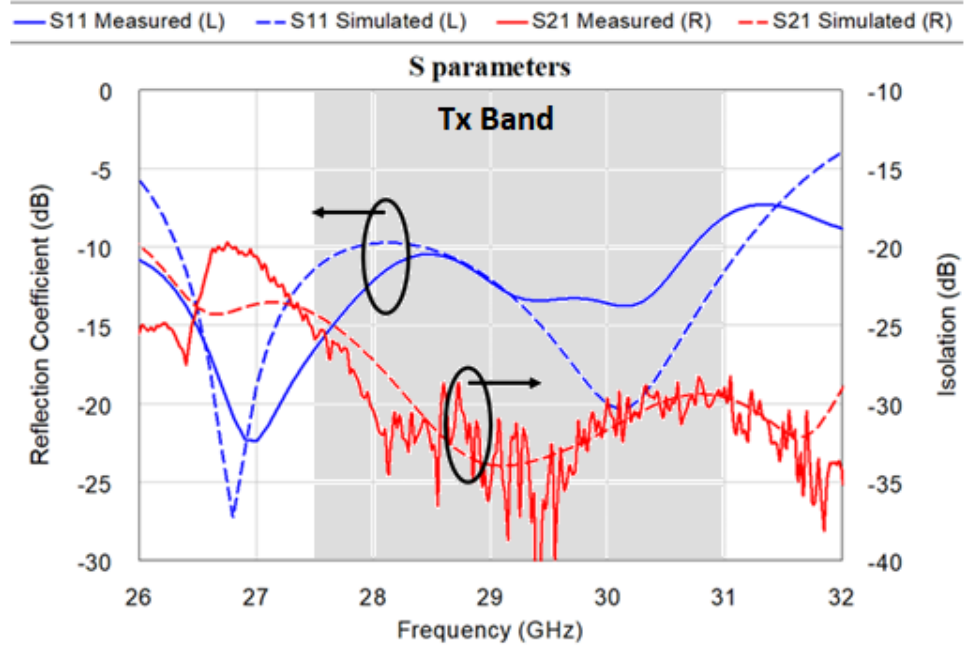
Figure 5. Return loss and isolation results for a single radiating element.